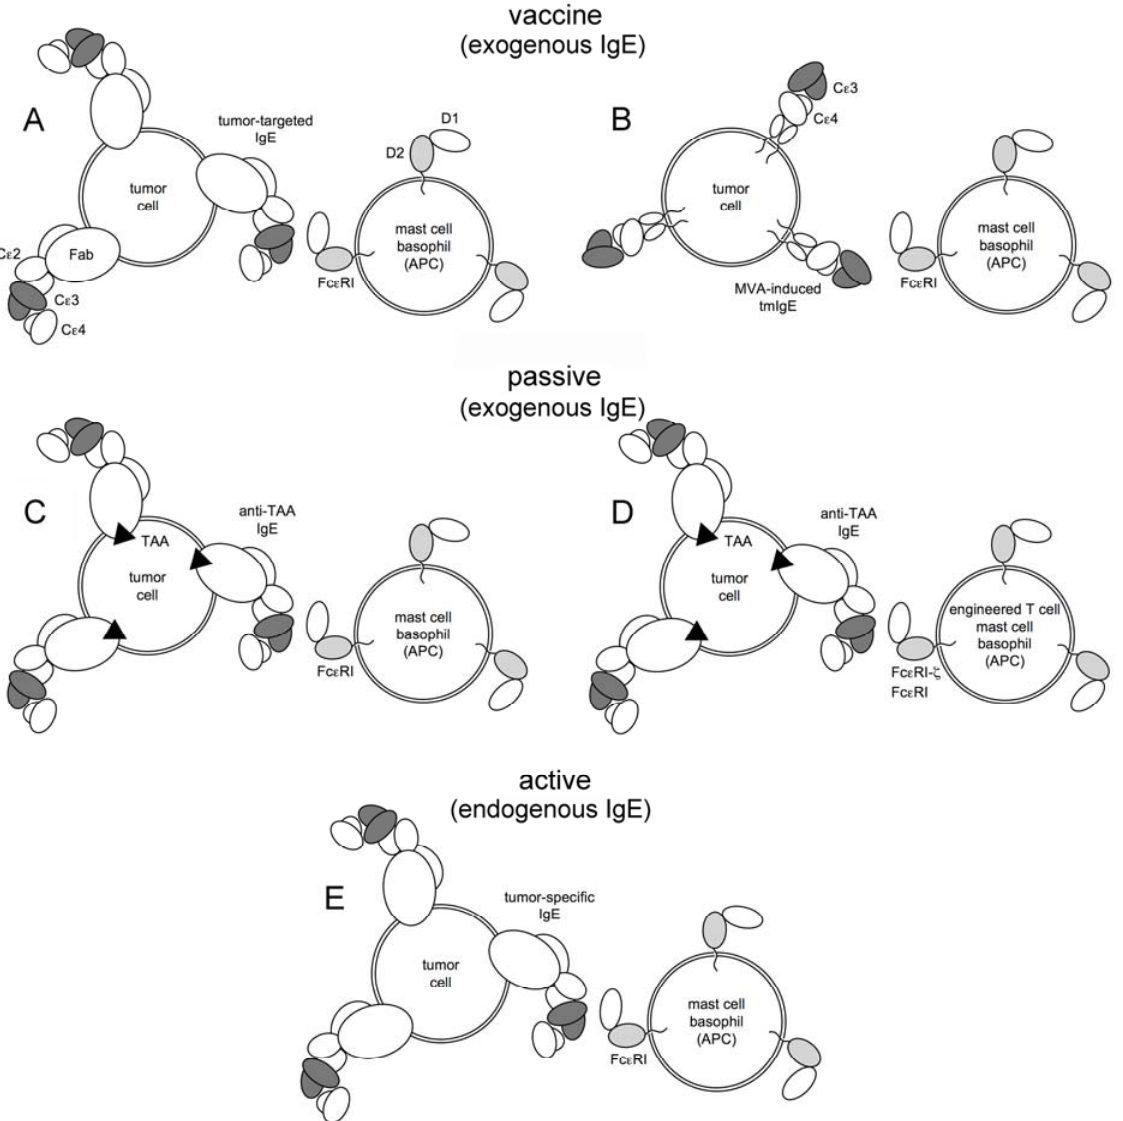
Figure 1. Schematic representation of the IgE-based approaches for vaccine, passive and active antitumor therapy. ( A ) Tumor cell targeting with complete IgE as vaccine adjuvant [67,68]. ( B ) MVA-induced tumor cell expression of a mini-membrane IgE (tmIgE) as adjuvant [69]. ( C ) TAA-specific IgE mAbs for passive therapy [70–80]. ( D ) Same approach as in C with a potentiation provided by Fc  RI-engineered CTLs [81,82]. ( E ) Active tumor therapy with the induction of endogenous tumor-specific IgE [83]. Mast cell and basophil Fc  RI has been reported as the major player in IgE recognition, however, when using the Fc  RI  -humanized mouse or in the case of a translation of these approaches from the mouse models to human clinical trials, other Fc  RI-expressing cells, particularly professional APC, are likely to be involved. TAAs are in black, the IgE binding site for Fc  RI and CD23 (C  3) is in dark grey and the Fc  RI binding site for IgE (D2) in light